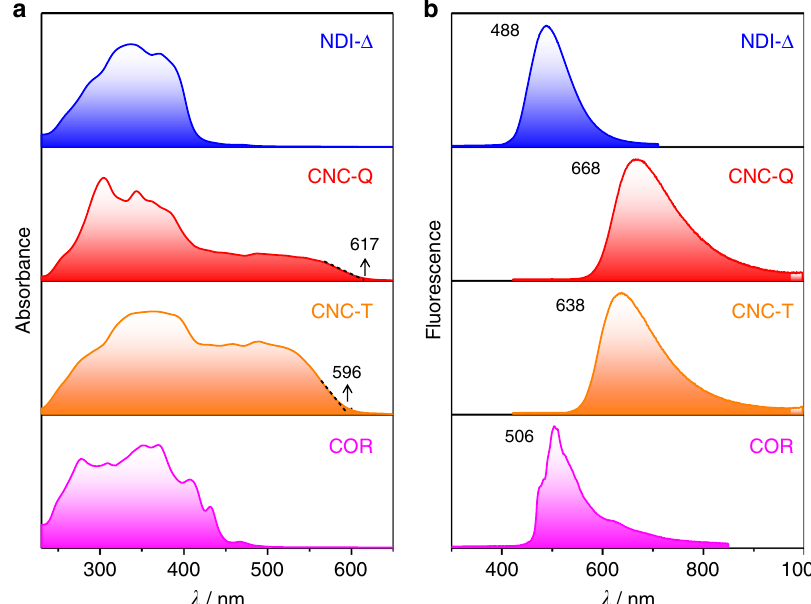
Fig. 4 Solid-state spectroscopic characterization. Solid-state a UV-Vis absorption and b fl uorescence spectra of NDI- Δ , CNC-Q , CNC-T and COR . The spectra of CNC-T and CNC-Q are signi fi cantly red-shifted compared to those of NDI- Δ and COR crystals. measurements reveal that both CNC-T and CNC-Q exhibit through-space electron sharing between NDI units in the NDI- Δ 41 (Supplementary Fig. 8), CNC-Q exhibits more ef fi cient (Supplementary Fig. 22) a double-exponential fl uorescence decay donor – acceptor overlap and stronger intermolecular charge- curve with an average lifetime of 11.4 and 9.7 ns, respectively. The transfer interactions compared with CNC-T . Consequently, CNC- radiative rate constant ( k r ) and non-radiative rate constant ( k nr ) of CNC-T are (Supplementary Table 4) 7.9 × 10 5 and 8.7 × 10 7 s − 1 , Q displays the more red-shifted absorption and emission spectra. respectively, while those for CNC-Q are 2.3 × 10 6 and 1.0 × 10 8 s − 1 . The larger k r and k nr values of CNC-Q are consistent with its faster fl uorescence decay lifetime when compared with that of CNC-T . Frontier molecular orbitals calculations . In order to attain a These observations indicate that the photophysical properties of co- deeper understanding of the electronic structures of the co- crystals are sensitive to their solid-state superstructures. On crystals, density functional theory (DFT) calculations were con- account of the different donor – acceptor stoichiometry and the ducted (Supplementary Figs. 31 – 34) with the B3LYP functional